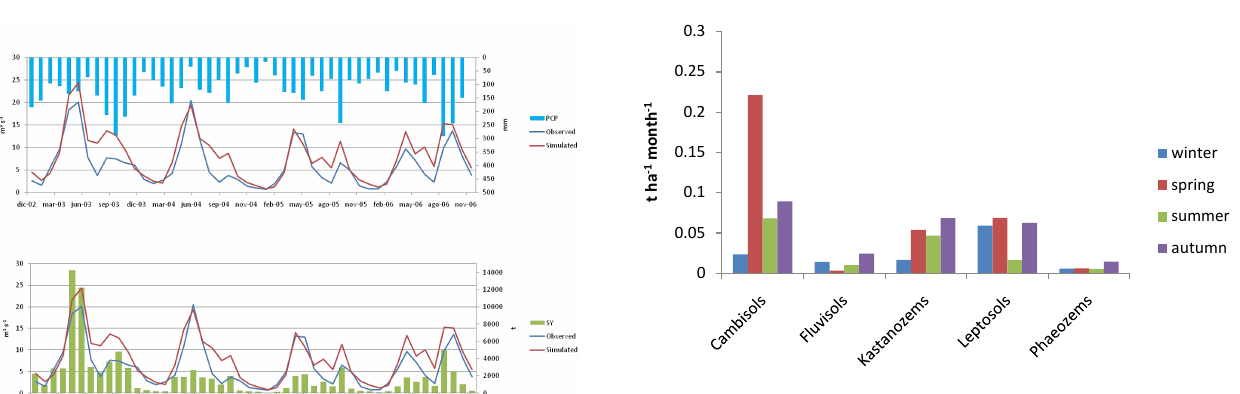
Figure 5. Seasonal distribution of simulated soil-specific sediment yield (tha − 1 month − 1 )